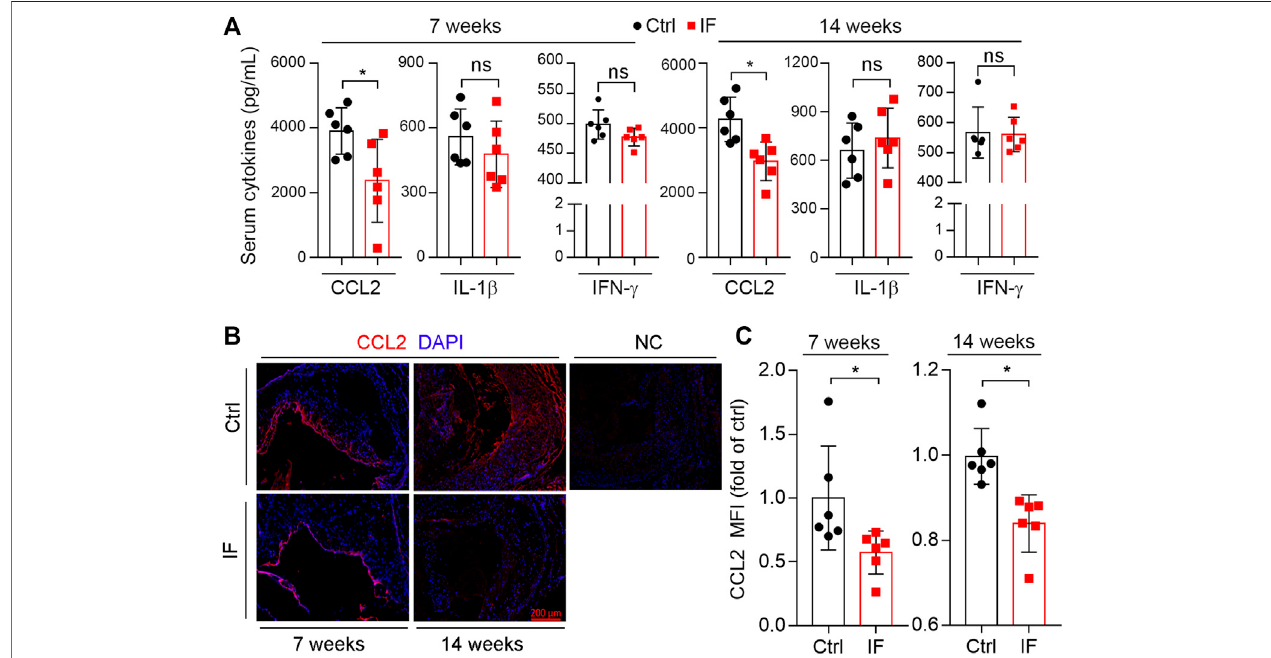
FIGURE 6 | Intermittent fasting suppresses CCL2 expression. (A) : mouse serum CCL2, IL-1 β , and IFN- γ levels were determined by the ELISA kits. (B,C) : aortic root cross sections were used to determine CCL2 expression by immuno fl uorescent staining with the quanti fi cation of CCL2-positive area (C) . * p < 0.05, ns: not signi fi cant ( n (cid:1)